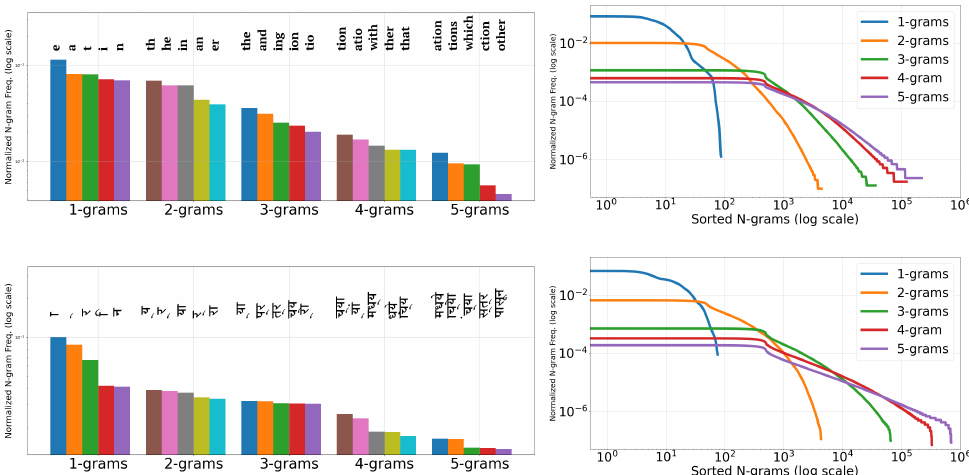
[ 1, 5 ] ) from 2.5 M words in English and Hindi (top to [ 1,5 ] ) from 2.5 M words in English and Hindi ( top to ∈ ∈